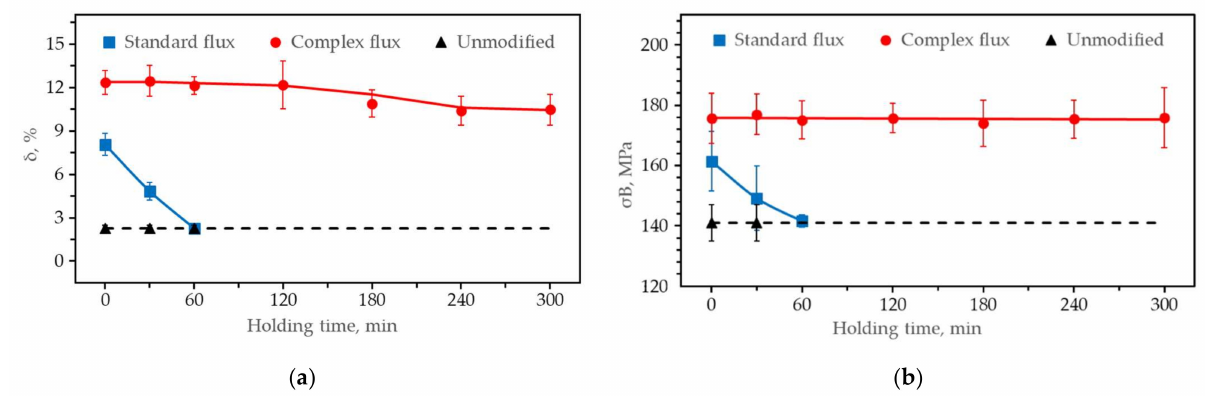
Figure 10. Influence of the holding time of the melt of the binary eutectic alloy Al-12% wt. Si (alloy 4) on the relative elongation ( a ), ultimate strength ( b ).